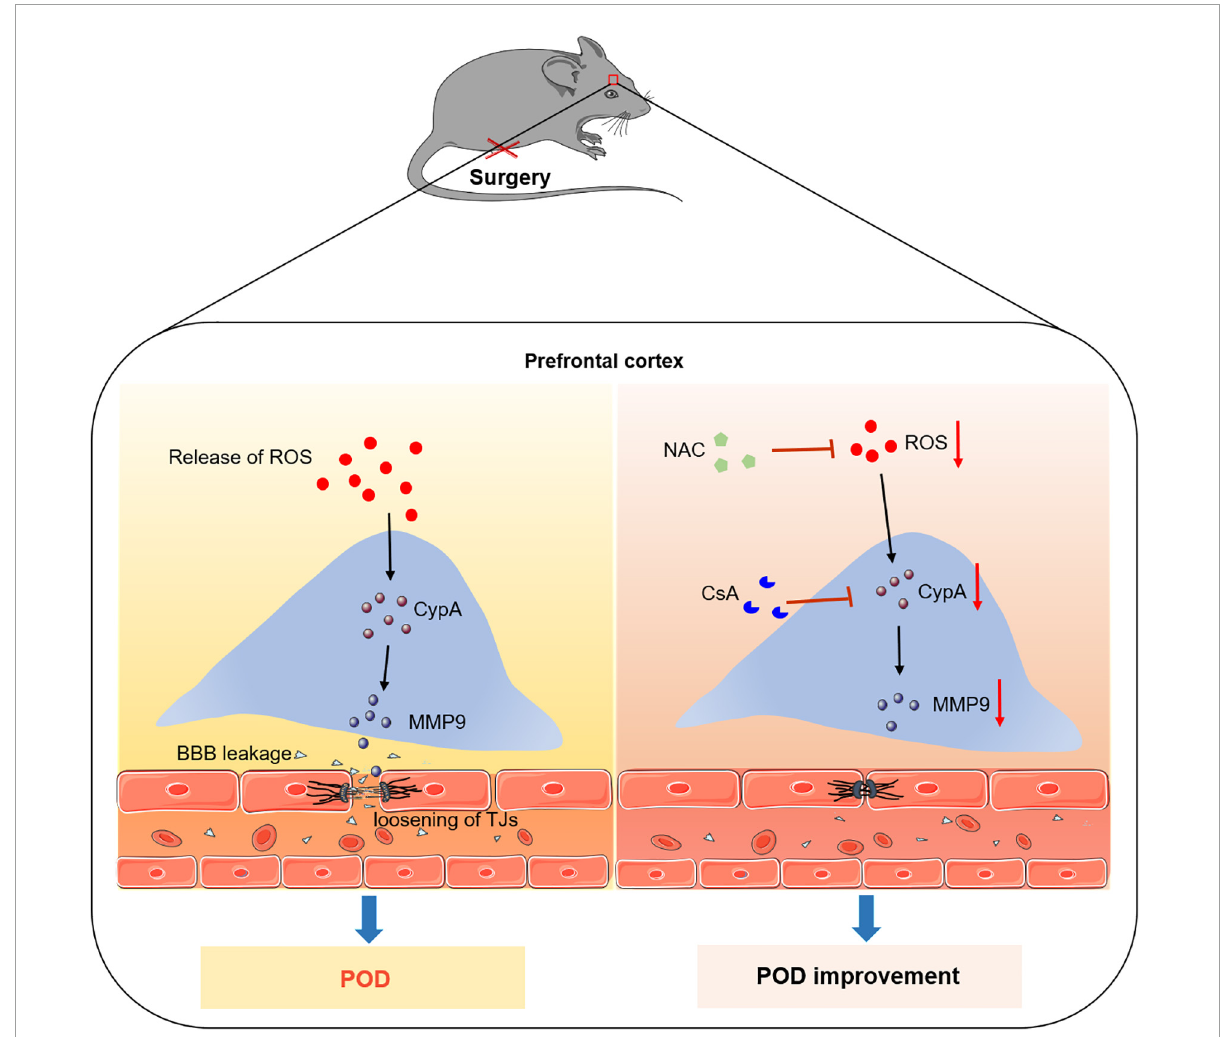
FIGURE6 Proposed pathway in the study. We find that the ROS scavenger alleviates anesthesia/surgery-induced CypA/MMP9 activation, BBB damage, and delirium-like behavior in mice. Furthermore, CypA inhibitor prevents BBB damage and delirium-like behavior by suppressing CypA/MMP9 pathway. These findings suggest that the ROS mediated CypA/MMP-9 pathway is a mechanism for inducing BBB injury and delirium-like behavior after anesthesia/surgery in aged